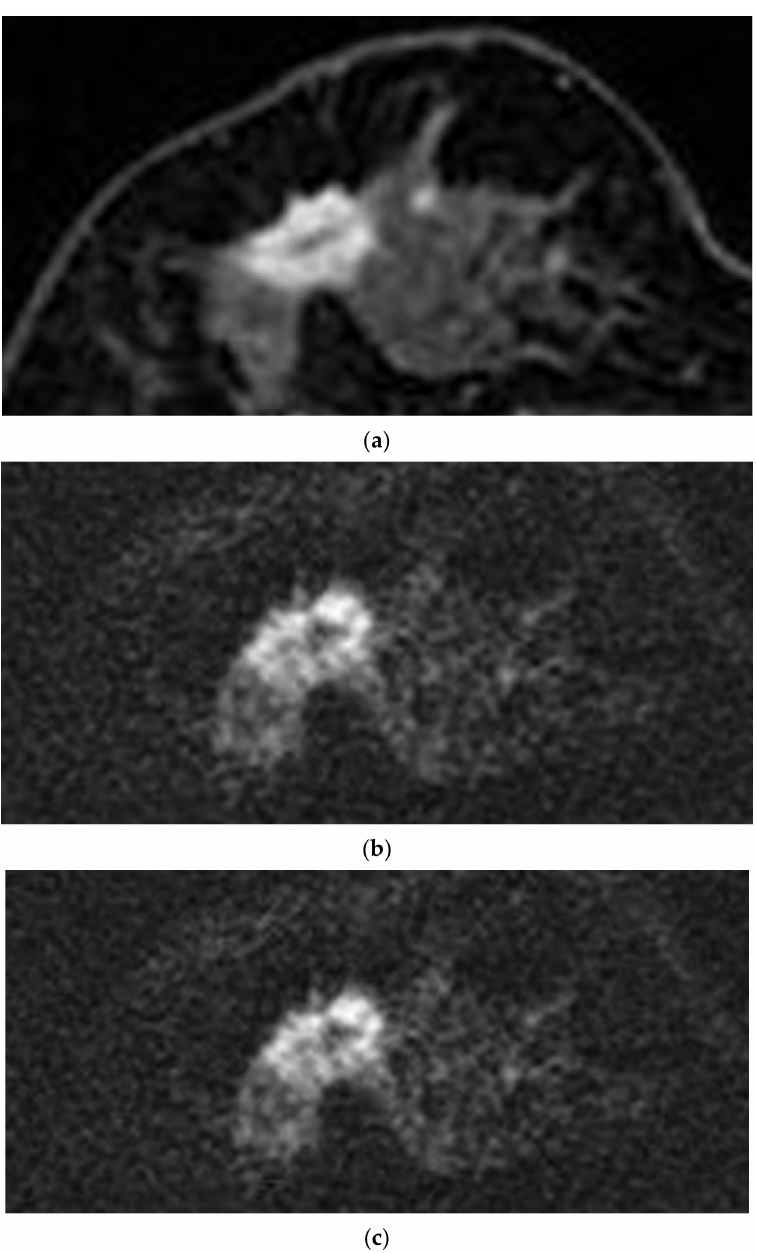
Figure 3. A 47-year old woman who was diagnosed invasive ductal carcinoma in her right breast. Axial contrast-enhanced T1-weighted fat-suppressed MRI ( a ) reveals a 16 × 12 mm-sized enhancing mass with irregular shape, spiculated margin, and rim, and marked enhancement is noted in the right breast at the 9 o’clock position. rFOVA-1000 a ( b ) and rFOVS-1000 b ( c ) also show index tumor well and had excellent depiction of shape irregularity and margin spiculation. a rFOVA-1000: acquired reduced field-of-view di ff usion-weighted images with b -value 1000 s / mm 2 . b rFOVS-1000: synthetic reduced field-of-view di ff usion-weighted images with b -value 1000 s / mm 2